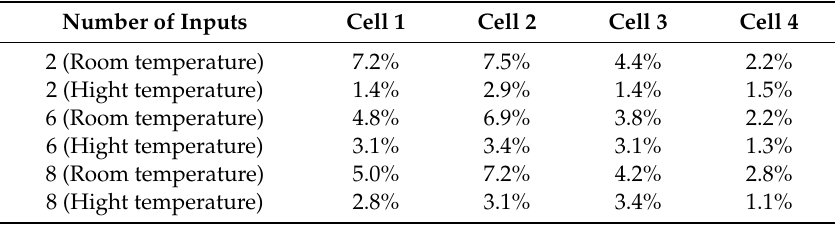
Table 2. Results of SOC estimation using the MNN according to the di ff erence in the number of inputs.